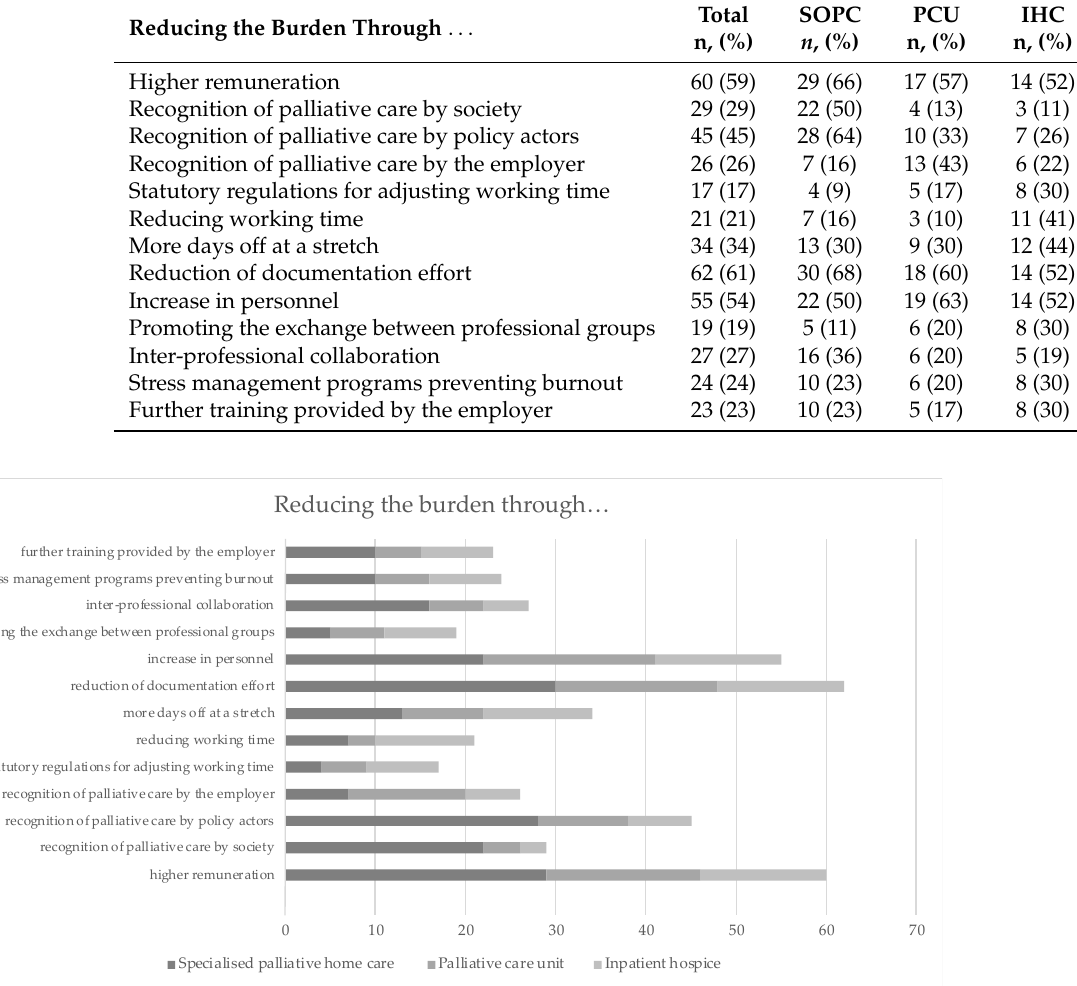
Figure 4. Measures to reduce burdens in different palliative care settings ( n = 101) .